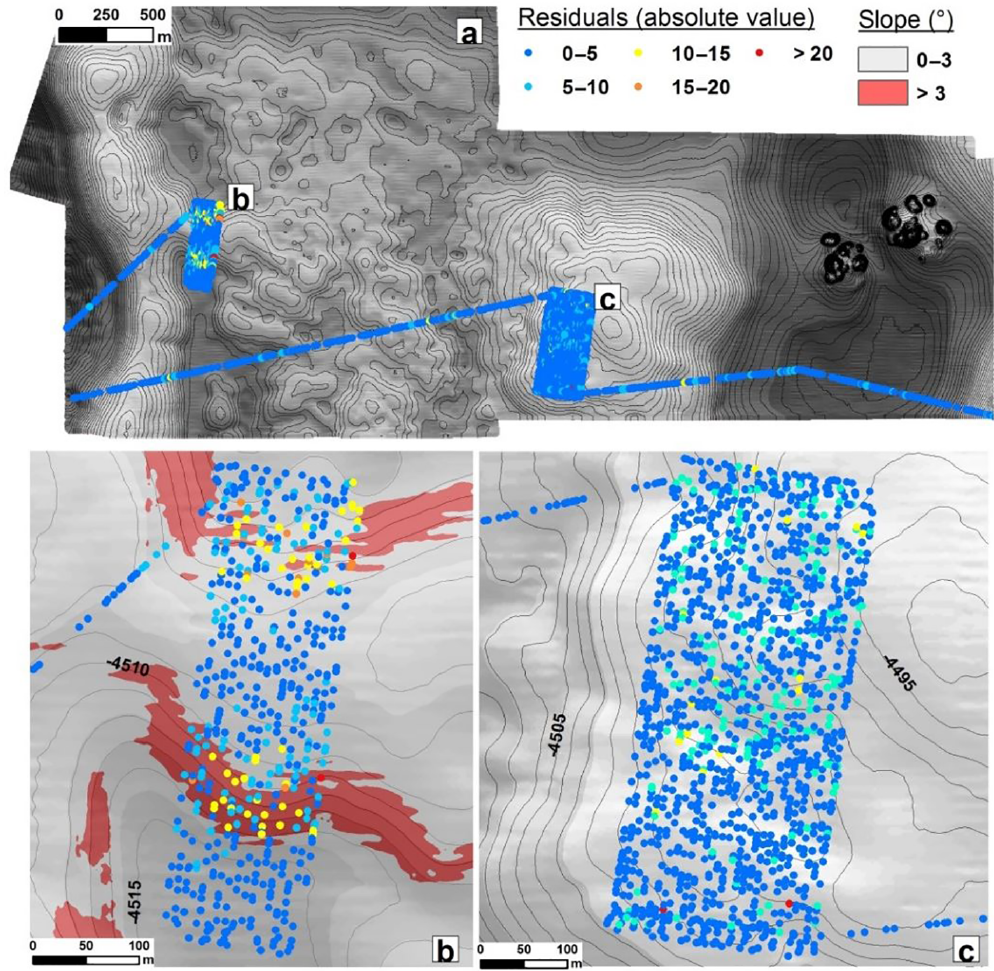
Figure B3. Spatial plotting of the RF residuals (absolute values). The intervals of their range are in accordance with the Table B10.